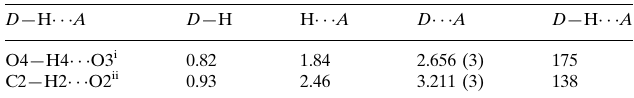
Hydrogen-bond geometry (A˚ , (cid:2)